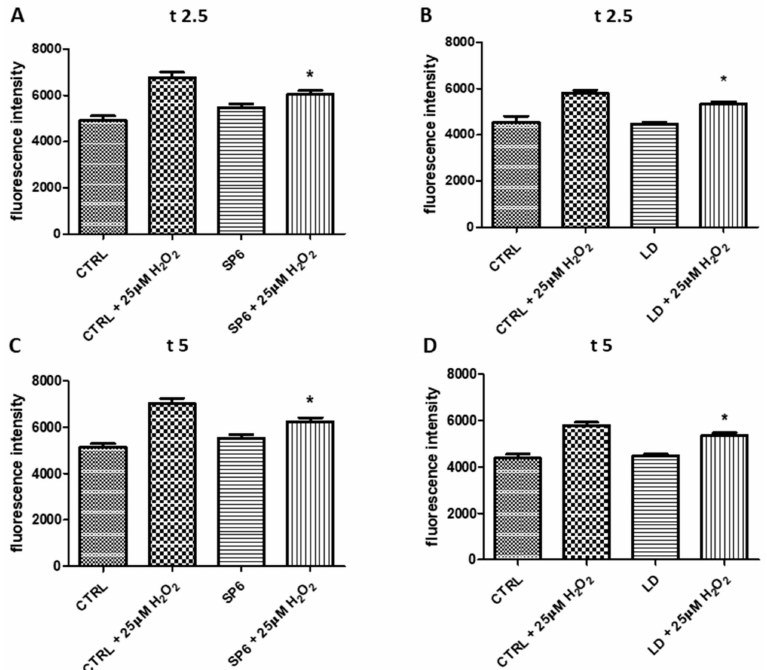
Figure 5. Measurement of the intracellular reactive oxygen species (ROS). The di ff erentiated SY-SH5Y cells incubated with 1 µ M SP6 (panels A and C ) or LD (panels B and D ) for 24 h, were treated with 25 µ M H 2 O 2 for 5 min. Figure 7 reported the fluorescence intensities at two points (t 2.5 and t 5 ) during the assays. The means ± SEM derived from two di ff erent experiments (each with n = 8; * 0.001 < p < 0.05; n.s., p >